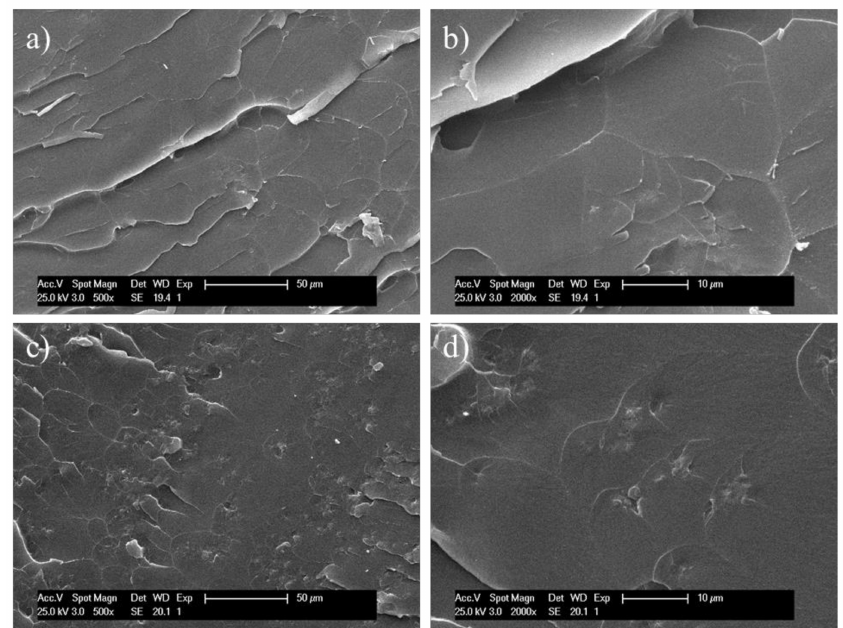
Figure 5. SEM micrographs of PANI / epoxy samples ( a ) and ( b ) 1 wt %, and ( c ) and ( d ) 3 wt %.